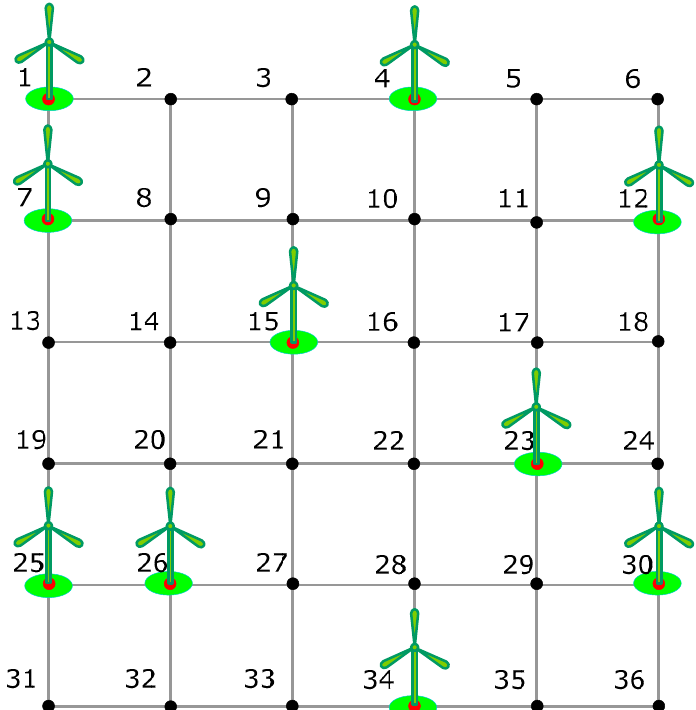
Figure 5. Optimal solution of the wind turbine placement problem considering mandatory wind turbine placement at specific locations.